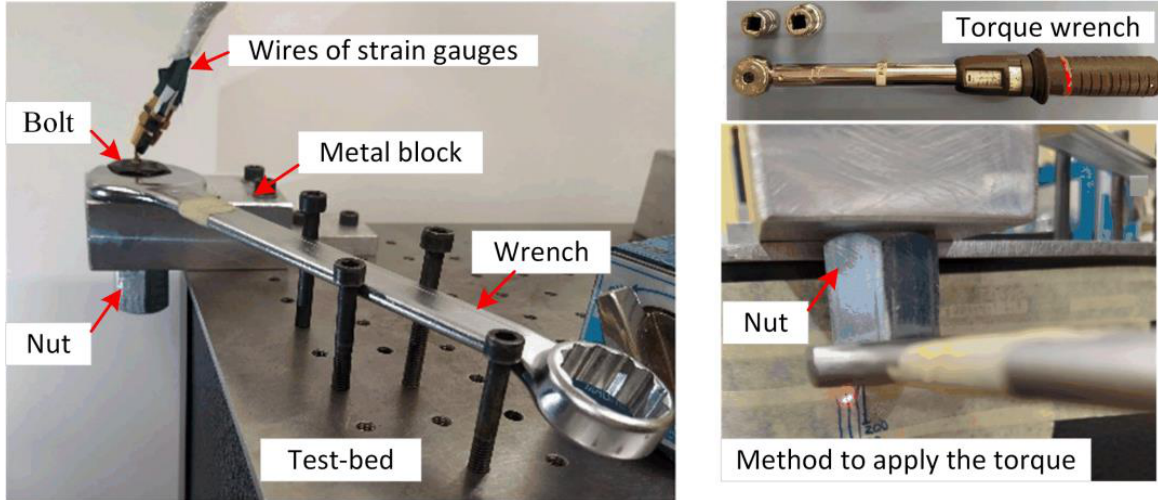
Figure 9. Setup to apply the tension preload through the torque wrench.